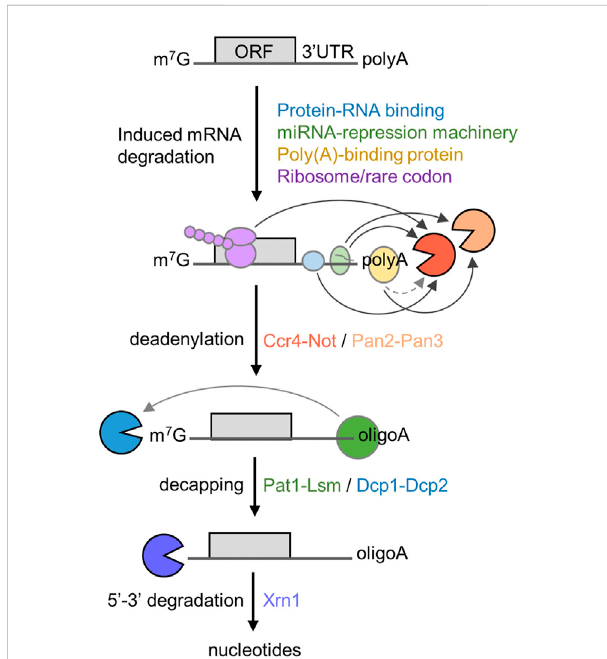
FIGURE 1 Role of deadenylation in the 5 ′ -3 ′ degradation pathway. Schematicdiagramofthe5 ′ -3 ′ mRNAdegradationpathway.Indicated areRNA proteins regulatingmRNA stability, thesequentialsteps ofthe 5 ′ -3 ′ degradation pathway, and protein complexes required. The open reading frame (ORF) and 3 ′ untranslated region (UTR) are indicated. Arrows indicate direct interactions between components; thedottedlineindicatesindirectinteractionsbetweenpoly(A)-binding protein and